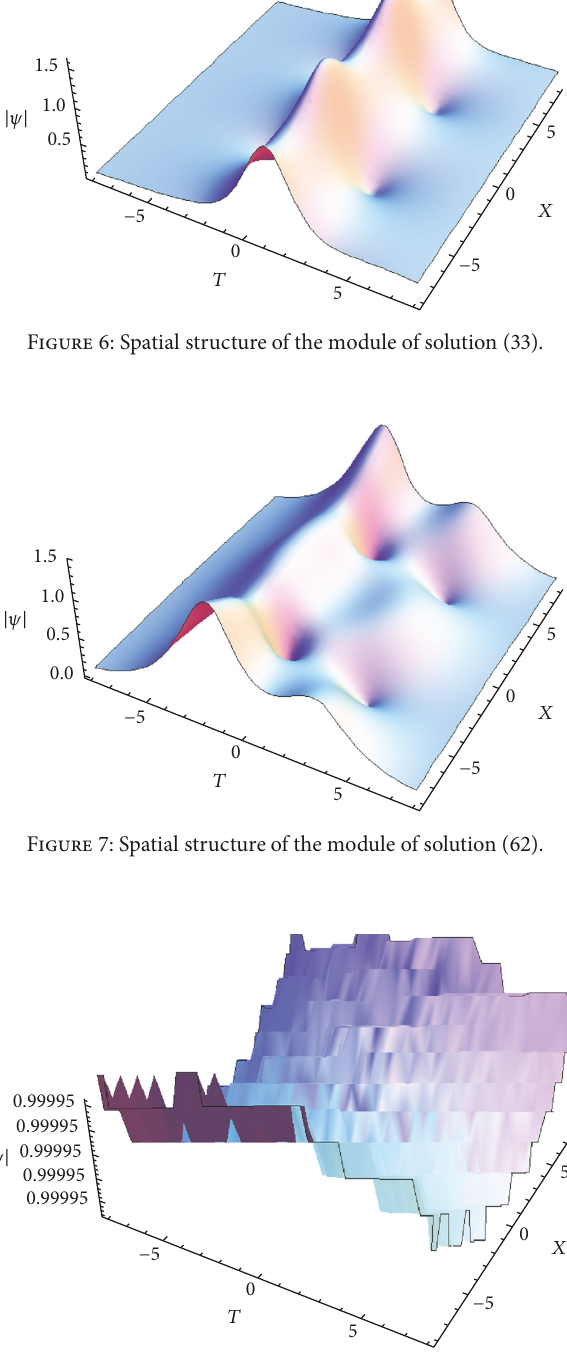
Figure 8: Spatial structure of the module of solution (81) with 𝑘 = 0.01